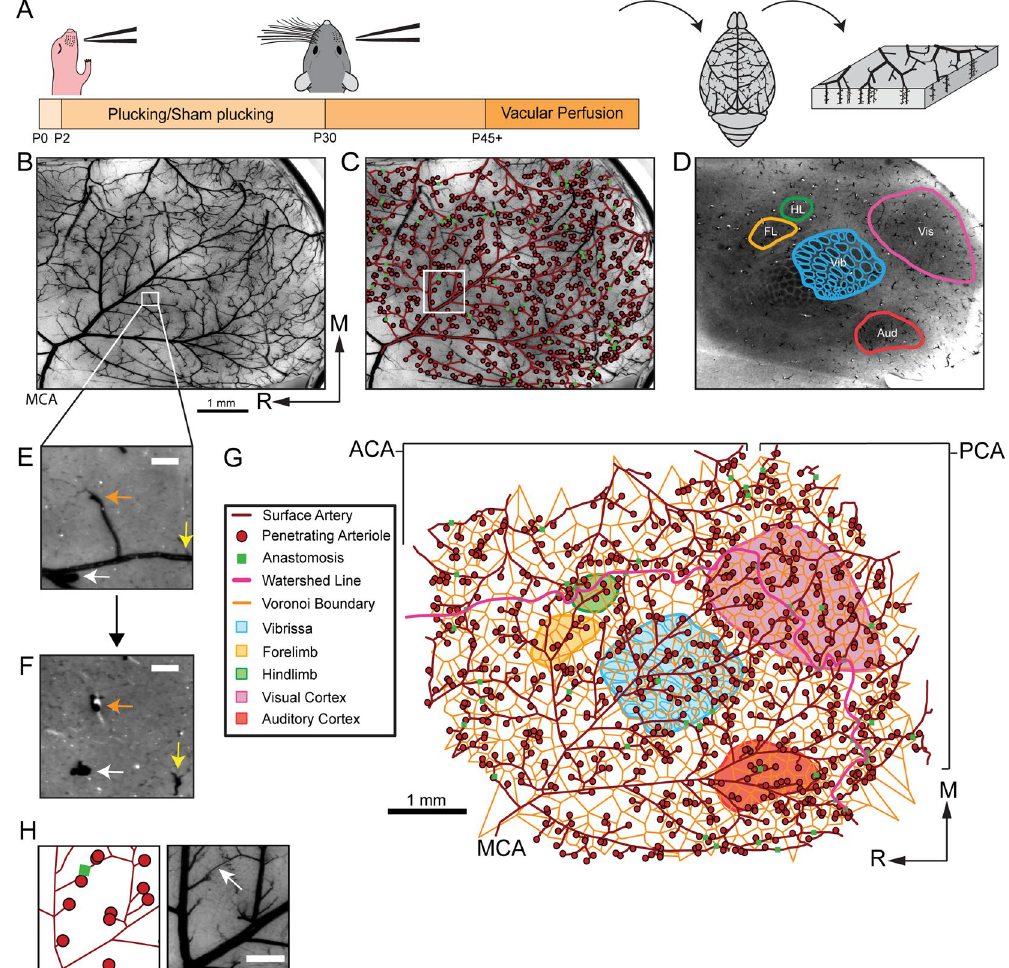
Figure 1. Reconstructing the pial arterial network with respect to the underlying neuroanatomy. ( A ) Schematic of experimental timeline. Whisker plucking/sham plucking was performed between P2 and P30, mice were sacrificed after P45. The vasculature was filled, the brain extracted, and the cortex flattened. ( B ) Photograph of a cortical slab. The Middle Cerebral Artery (MCA) is labeled in the bottom left corner. Scale bar: 1 mm. ( C ) The arterial vascular tracing overlaid on a picture of the slab vasculature. The arterial backbone is depicted in dark red. Penetrating arterioles (PAs) are depicted as red circles, and leptomeningeal anastomoses (LMAs) are shown as green squares. ( D ) Tangential section stained for CO, with S1 (vibrissae, forelimb, and hindlimb regions), visual, and auditory cortices denoted by colored lines. ( E ) Zoomed image of filled vasculature in (B). The white, orange, and yellow arrows point to penetrating arterioles (PAs). Scale bar: 100 µ m. ( F ) A tangential slice taken just below the image in (E) demonstrating that a PA location can be verified by following it into the parenchyma. Colored arrows denote the same PAs noted in the previous image. ( G ) The completed pial arterial vascular reconstruction, including the anatomically-identified cortical regions, Voronoi cells centered around PAs (orange), and watershed line (pink) between the Anterior Cerebral Artery (ACA) and MCA, and Posterior Cerebral Artery (PCA) and MCA. Note that PAs and LMAs are both vessels, though they are denoted by point markers. Scale bar: 1 mm. ( H ) Zoomed image of anastomoses (box in C). Scale bar: 0.25